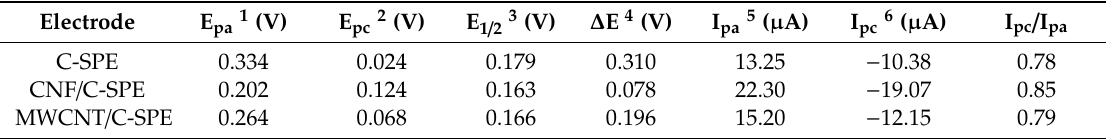
Table 2. Electrochemical parameters obtained from the sensor cyclic voltammograms of electrodes